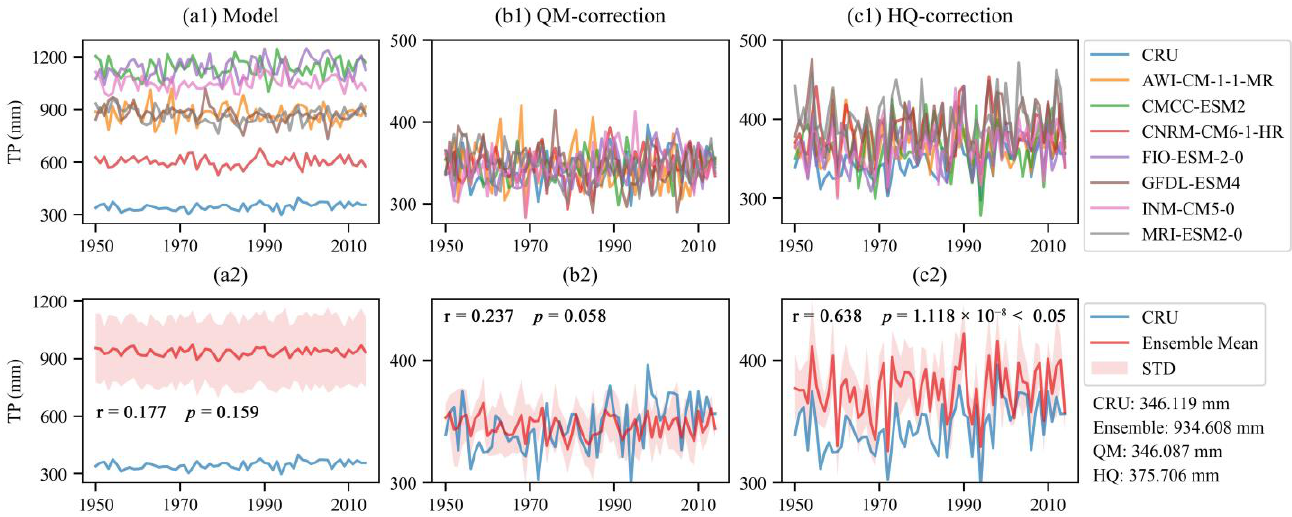
Figure 4. The curve of annual total precipitation over time in the historical scenarios. ( a1 , a2 ) are the comparison of the single model and the ensemble model with CRU data, respectively. ( a – c ) are the comparisons of the original, the QM-corrected, and the HQ-corrected precipitation, respectively (r is the Pearson correlation coefficient).